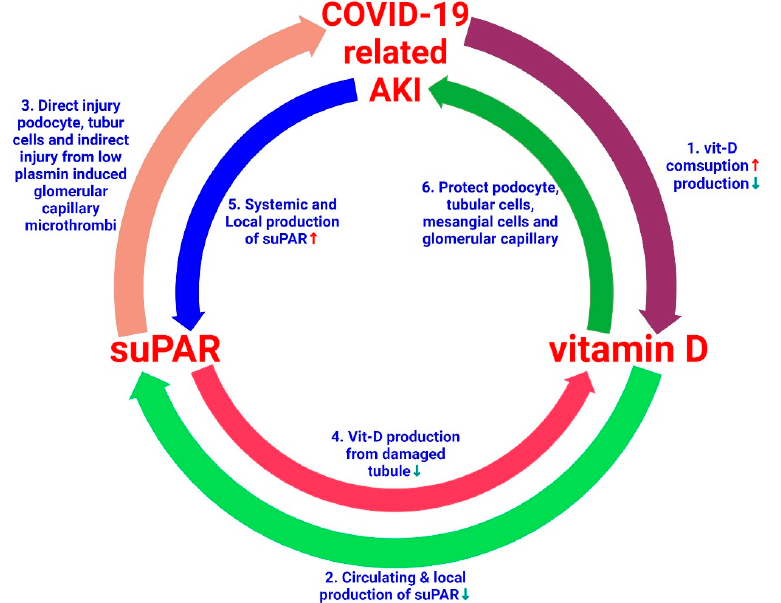
Figure 5. A putative cross-talk between vitamin D, suPAR, and COVID-19-related AKI. (1) Patients with COVID-19-related AKI have increased consumption and reduced kidney capacity to produce vitamin D, which may lead to vitamin D deficiency. (2) Vitamin D insufficiency or deficiency increases suPAR production from myeloid cells and podocytes. The addition of vitamin D suppresses local and systemic suPAR levels. (3) A high level of suPAR causes various lesions in the kidney cells such as tubular cells, podocytes, endothelial cells, and mesangial cells. (4) High levels of suPAR damage the renal tubular cells, resulting in a decrease in vitamin D production. (5) Patients with COVID-19-related AKI may have increased systemic and local suPAR levels. (6) Vitamin D supplementation can protect podocytes, tubular cells, and mesangial cells and prevent microthrombus formation in the glomerular capillaries and other vascular structures.